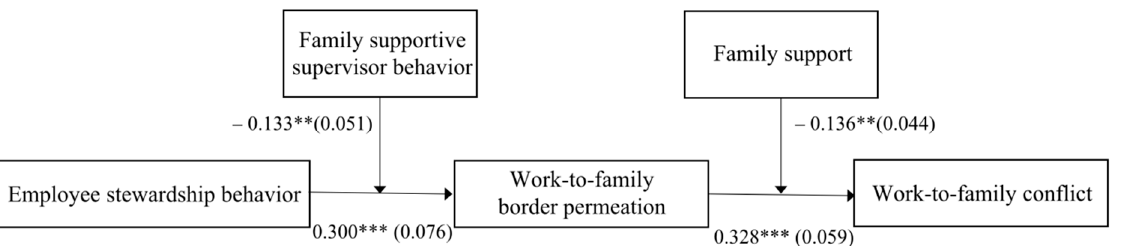
Figure 4. Path coefficient analysis model. Note(s): For brevity and clarity, only the main path coefficients of the full model (unstandardized) are presented in this figure. ** p < 0.01, *** p < 0.001.